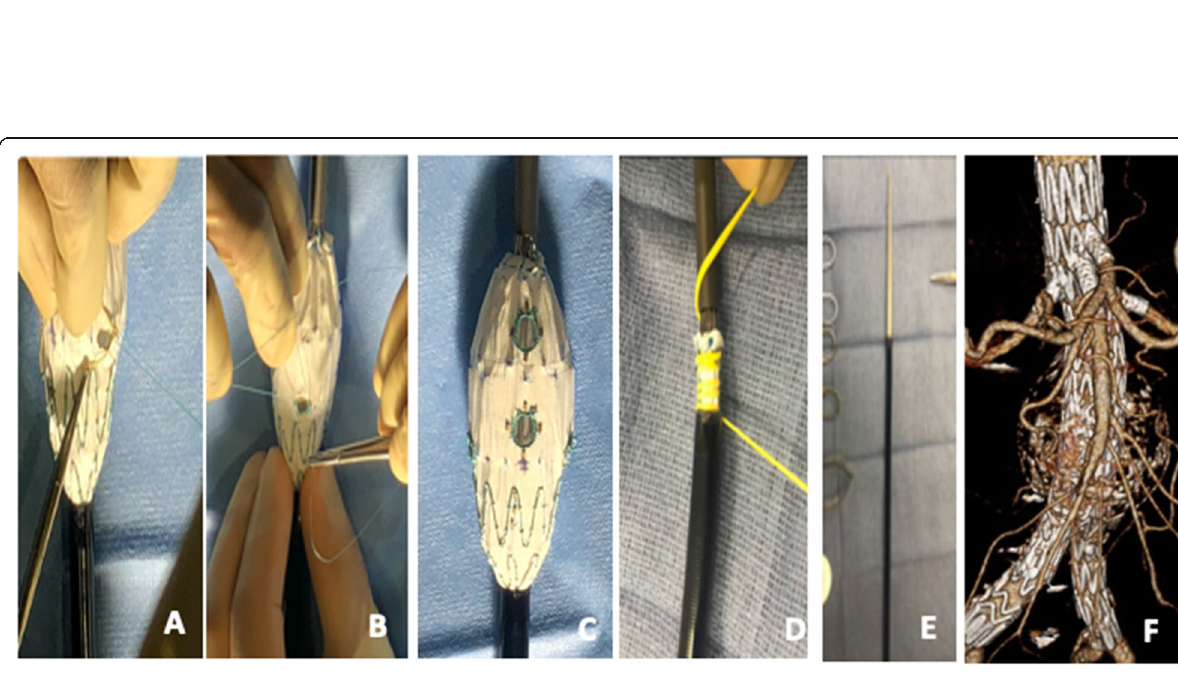
Fig. 5 A-F . Steps involved in modification of the Zenith fenestrated stent graft (Zfen). The device is already constrained posteriorly and comes with 2 fenestrations created by the manufacturer to accommodate the celiac and superior mesenteric artery. Modification requires only partial deployment of the graft ( A ). Fenestrations are created and reinforced as described in Fig. 5C. ( A, B, and C ). The device is collapsed with silastic loops ( D ) and resheathed (E ). Follow up post-operative 3D CTA confirm continued aneurysm exclusion and patency of target vessels. Rationale for device selection : Zfen is by far the easiest device to modify as it is already constrained and modification only requires addition of desired fenestrations and resheathing. This is our device of choice for all elective cases